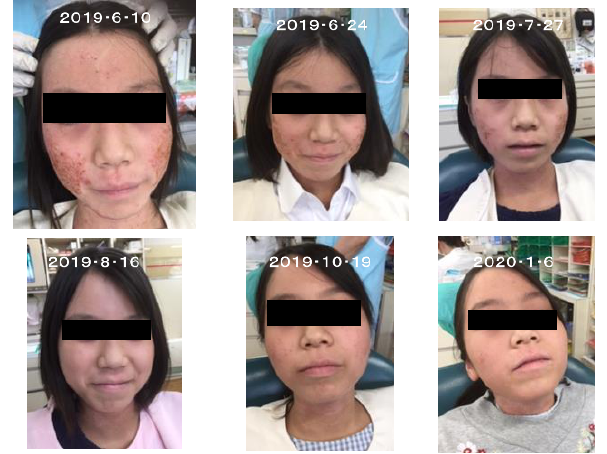
Figure 9. Improvement of atopic dermatitis by the treatment with forsythia leaf decoction